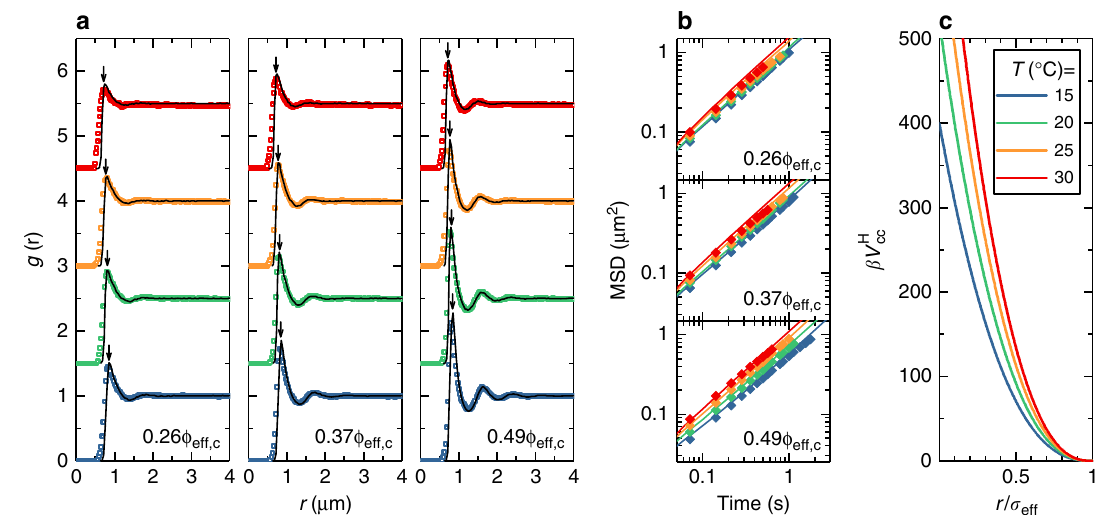
Fig. 1 Temperature-dependent structure, dynamics and interaction potential of one-component microgel suspensions. Symbols indicate experimental data, solid lines represent simulations. Color legend applies to all panels. a Radial distribution functions g ( r ) from simulations and experiments. Panels show data ¼ 0 : 26 ; 0 : 37 and 0.49 (left to right, evaluated at T = 15°C) for 15°C ≤ T ≤ 30 °C. Graphs are offset along the y -axis for clarity. Downward pointing for ϕ eff ; c arrows indicate the hydrodynamic diameter of colloids at each T . b MSDs for 15 °C ≤ T ≤ 30 °C reconstructed from the x , y trajectories, i.e. 〈 x 2 + y 2 〉 , with ¼ 0 : 26 ; 0 : 37 and 0.49 (from top to bottom). c Hertzian interaction potential at different temperatures: U ϕ eff ; c 25, 30 °C respectively. The distance is rescaled by σ eff = 2 R